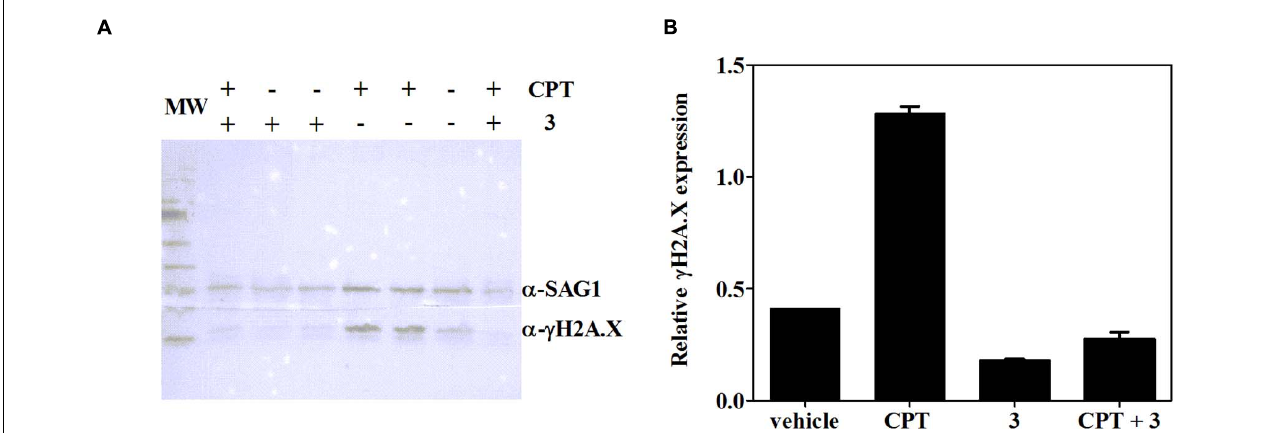
FIGURE 6 | (A) Expression of T. gondii γ H2A.X evaluated by western blot after 2 days of treatment with CPT (10 µ M), 3 (7.5 µ M), CPT (10 µ M) + 3 (7.5 µ M) or the vehicle (DMSO). (B) Density measurements of western blot bands, relativized to SAG-1